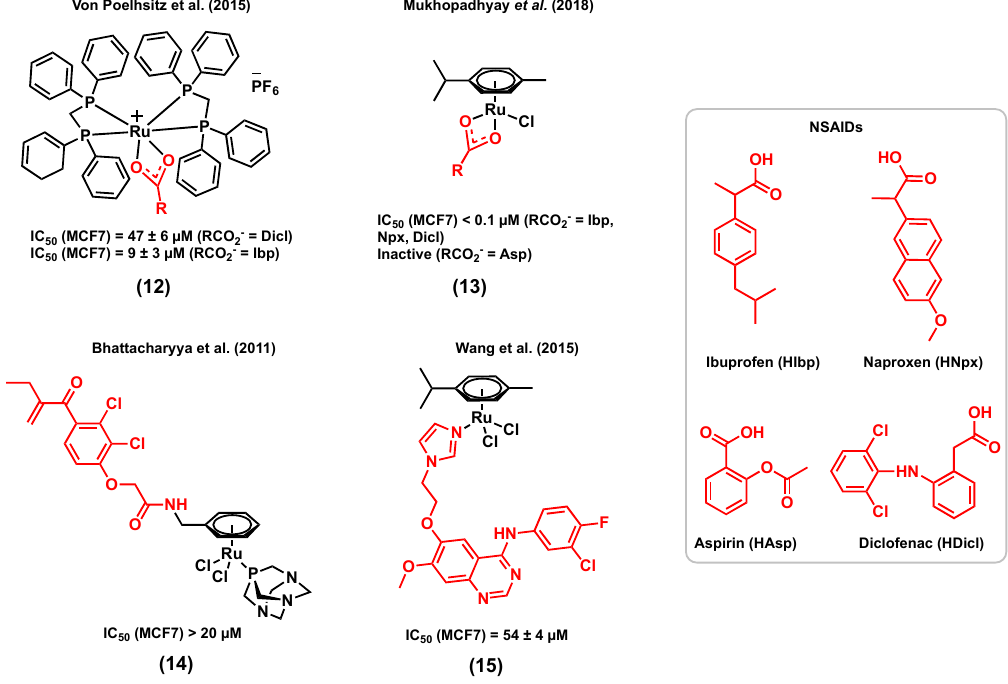
Figure 3. Ruthenium complexes bearing bioactive ligands.